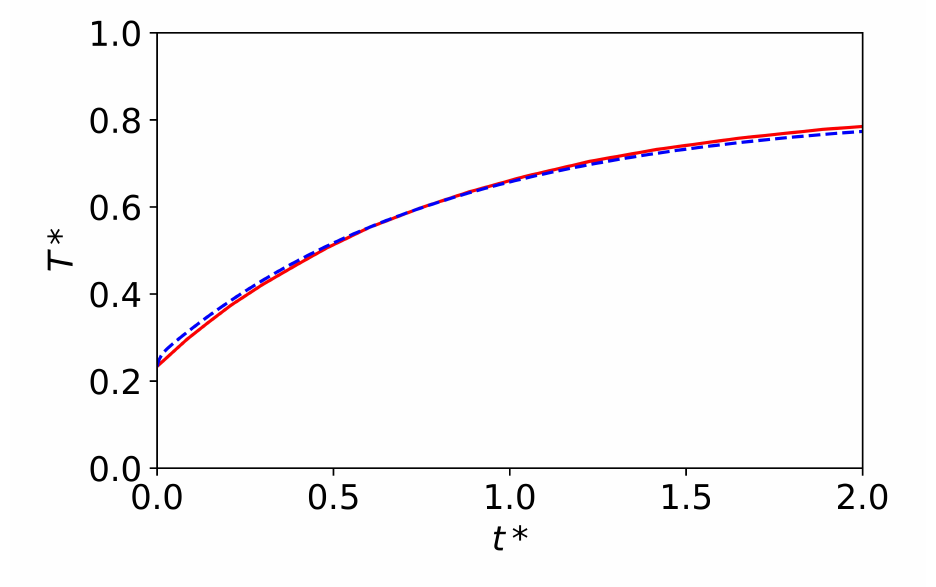
Figure 6. Average battery pack temperature during the heat-up test: Measured ; simulated